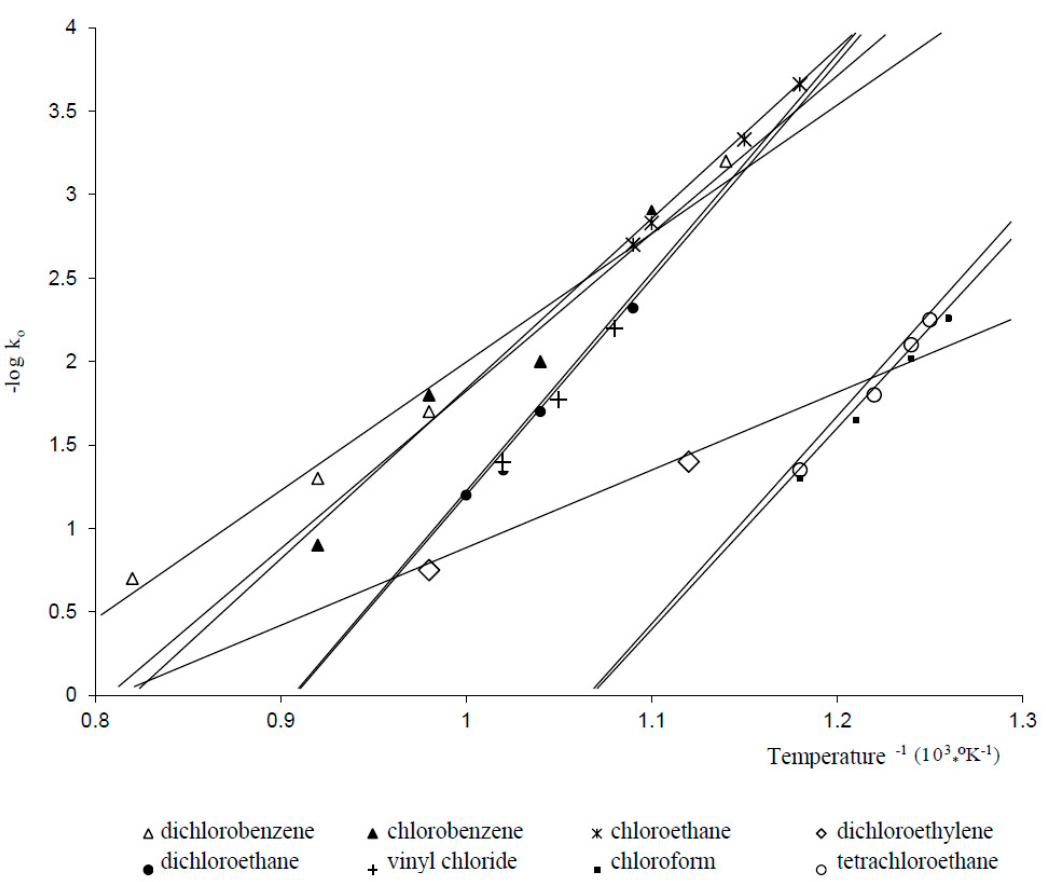
Figure 4. Temperature dependence of the process rate constants for different chlorohydrocarbons.